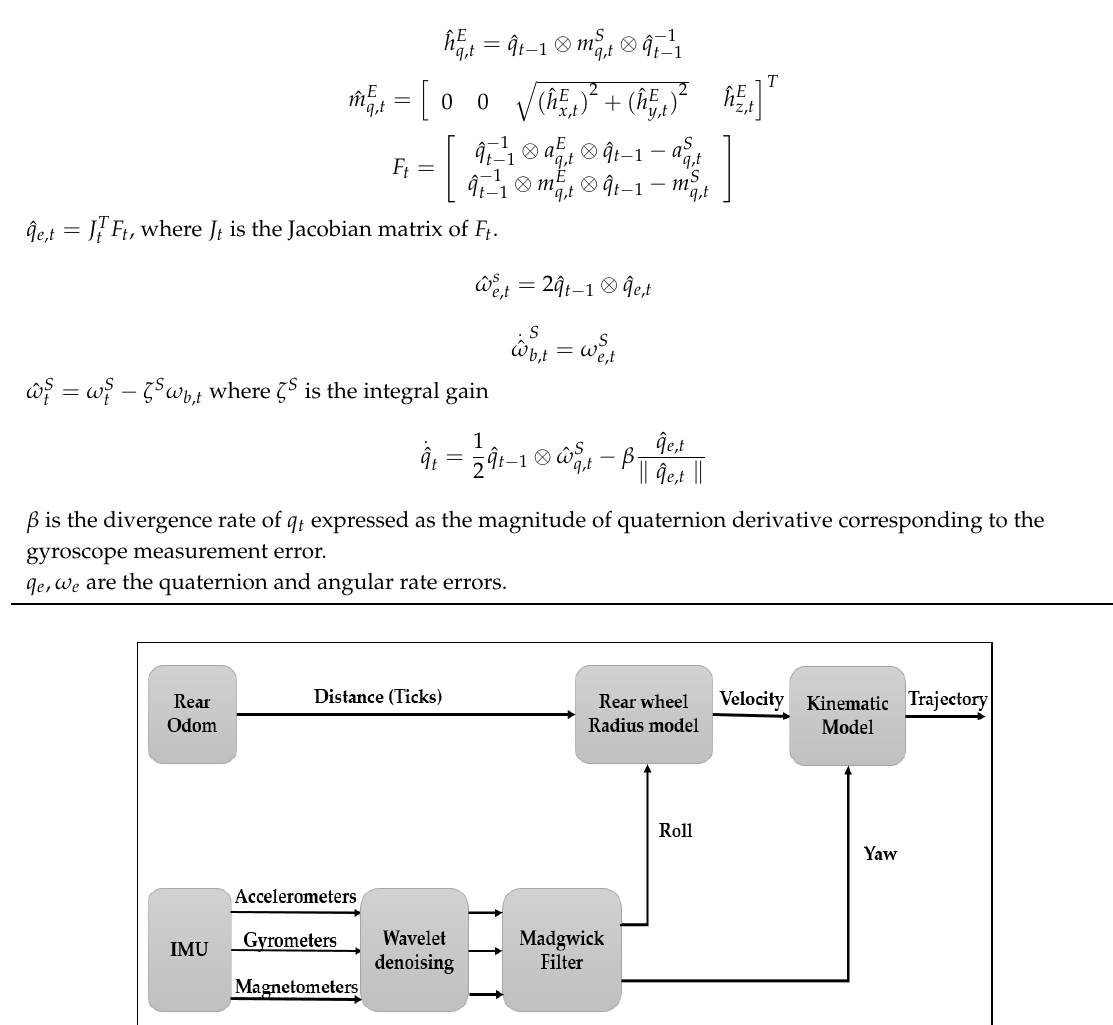
Figure 13. Schematic diagram of the new INS/odometer integration model.